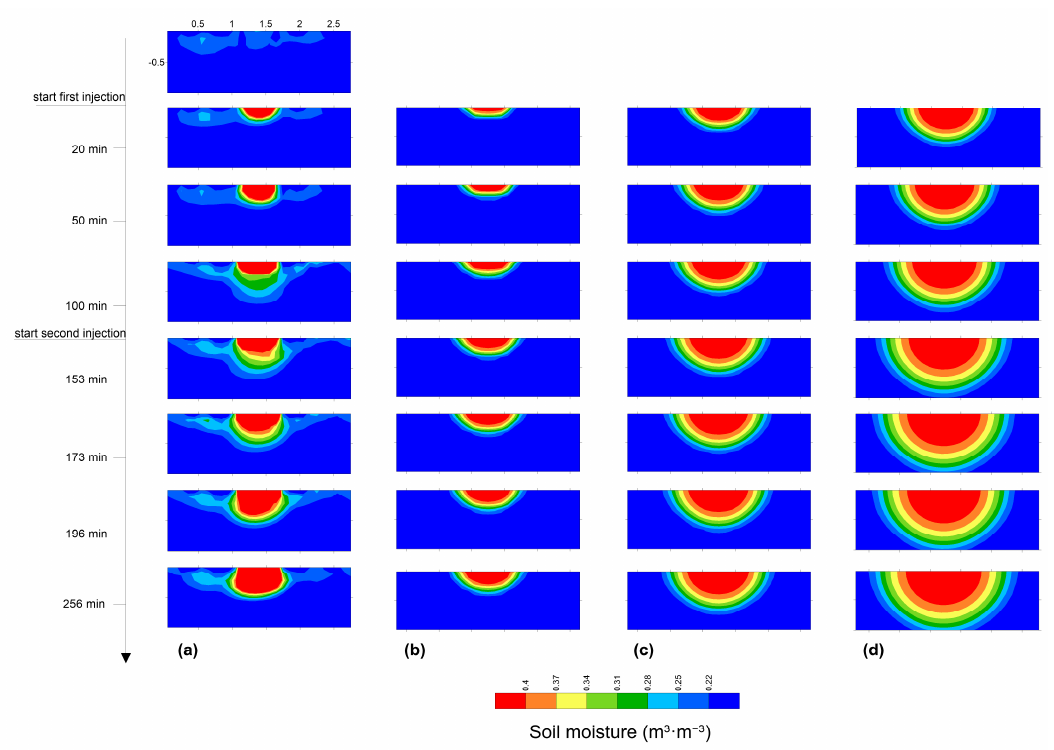
Figure 6. Comparison of the ERT-derived water content ( a ) and the simulated one for three different scenarios: ( b ) scenario A; ( c ) scenario C; and ( d ) scenario E.